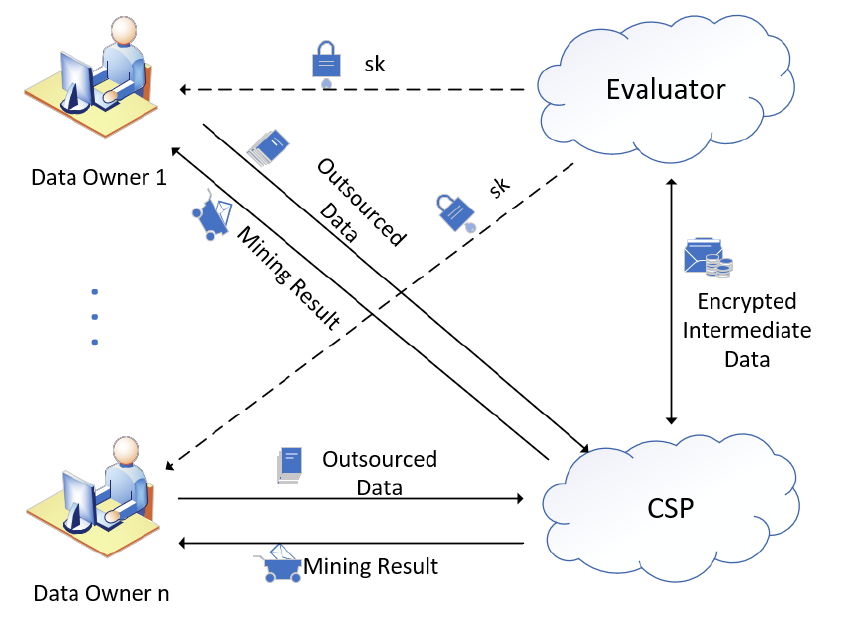
Figure 1. System